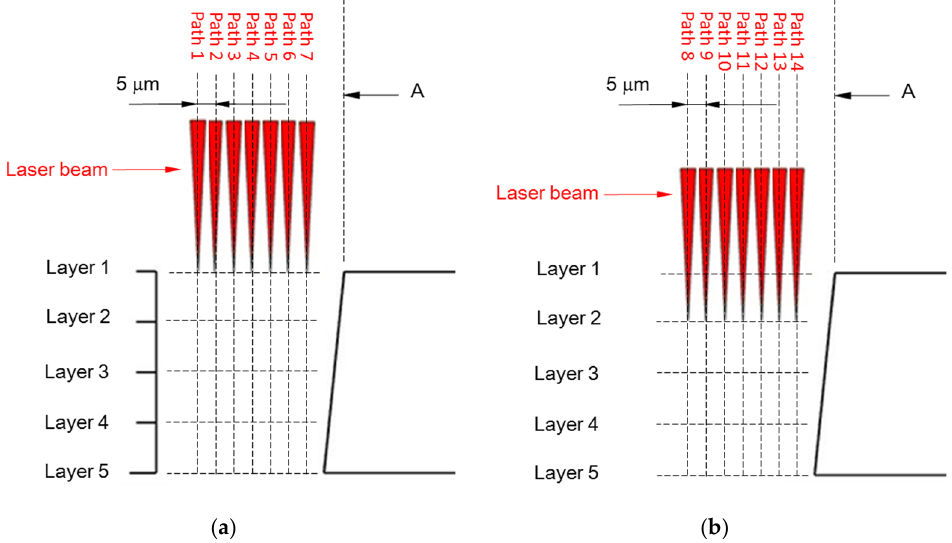
Figure 4. Laser finishing Method 3: ( a ) 7 paths of laser finishing, from Path 1 to Path 7, were conducted in Layer 1 with 6 horizontal shifts. The finishing was performed with 20 passes per path and horizontal space shift of 5 µm between paths; ( b ) The stage was lifted in the vertical direction along the Z-axis for processing Layer 2. Path 8 to path 14 were conducted in the layer with 6 horizontal shifts. The stage lift in the Z-axis was 100 µm, and the total number of stage lifts was 4 (5 layers in total).